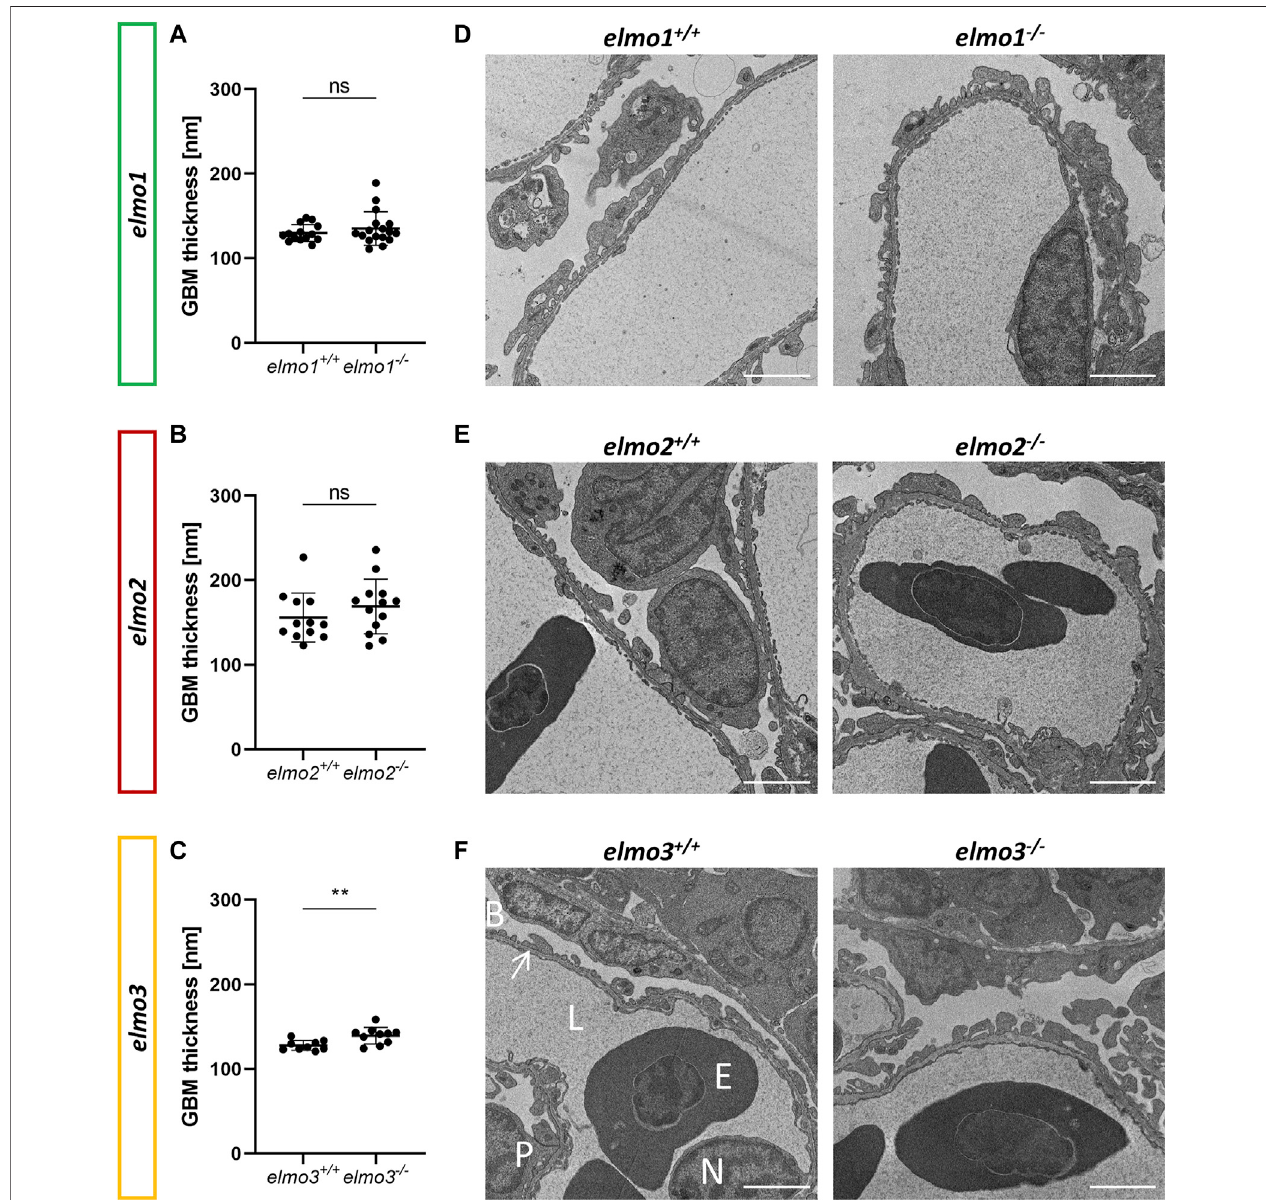
FIGURE5| ThelossofElmo3ledtoathickeningoftheglomerularbasementmembraneinadultzebra fi shkidneys. (A) Quanti fi cationofthethicknessoftheGBMin the adult kidney (9 – 15 mpf) showed no alterations in elmo1 − / − compared to littermate elmo1 +/+ . n = 14 – 17 per group. Each is the mean thickness per one glomerulus. (B) Quanti fi cation of the thickness of the GBM in the adult kidney showed no alterations in elmo2 − / − compared to littermate elmo2 +/+ . n = 12 – 13 per group. Each is the mean thickness per one glomerulus. (C) Quanti fi cation of the thickness of the GBM in the adult kidney showed an increase of the GBM thickness in elmo3 − / − compared to littermate elmo3 +/+ . n = 9 – 10 per group. Each is the mean thickness per one glomerulus (D – F) Representative electron microscopy images of glomerulus sections of adult zebra fi sh kidneys of elmo1 +/+ and elmo1 − / − (D) , elmo2 +/+ and elmo2 − / − (E) and elmo3 +/+ and elmo3 − / − (F) . Exemplarily glomerulus compartments as GBM (arrow), Bowman space (B), endothelial cell nucleus (N), capillary lumen (L), podocyte (P) and erythrocyte (E) are indicated in white. Scale bar is 2 µm. Statistical analysis was done with t -test and Mann-Whitney test. ** p < 0.01. ns, not signi fi cant; GBM, glomerular basement membrane; mpf, months post fertilization.